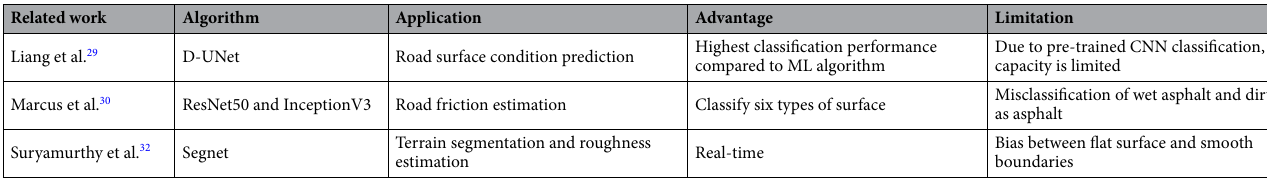
Table 1. Summary of related